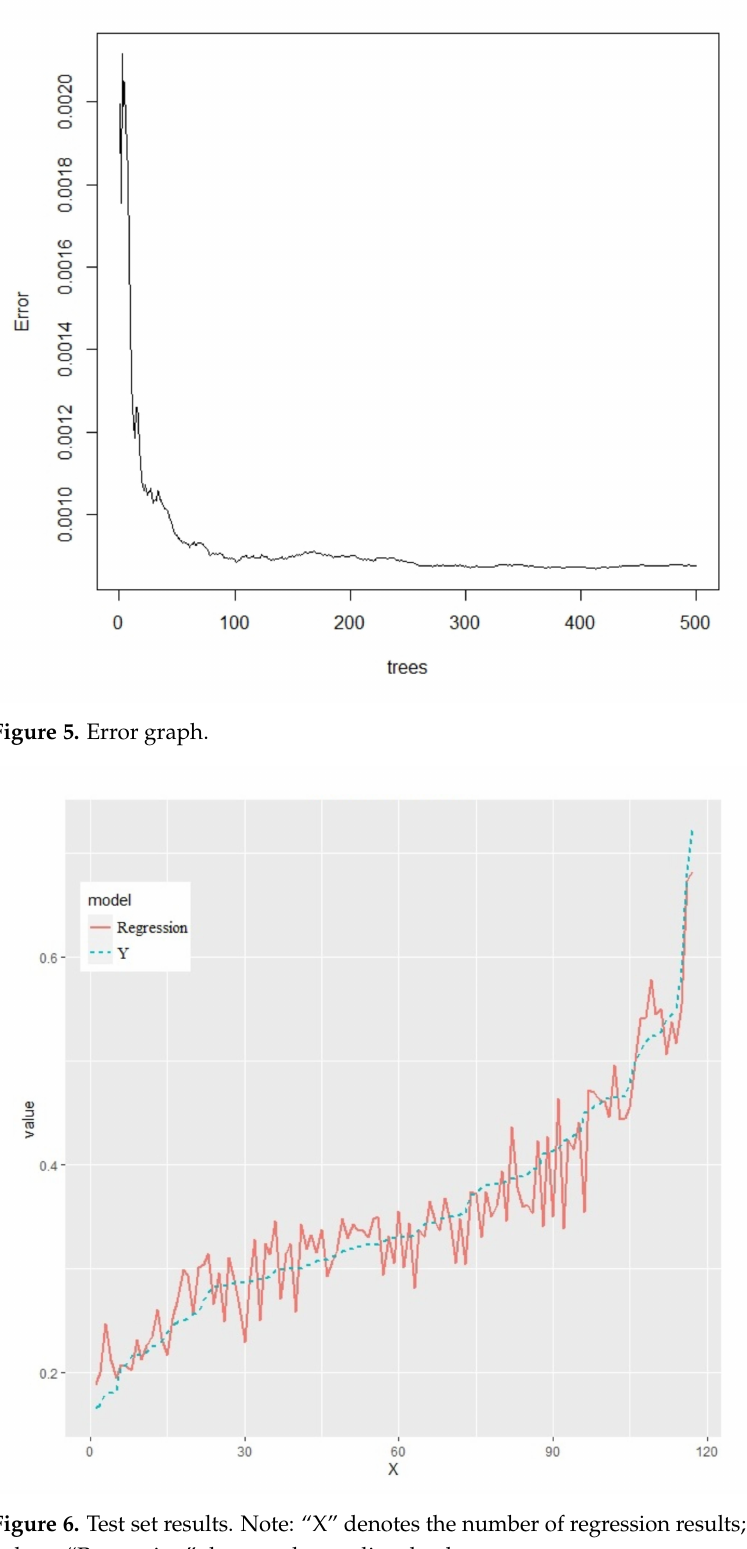
Figure 6. Test set results. Note: “X” denotes the number of regression results; “Y” denotes the actual values; “Regression” denotes the predicted